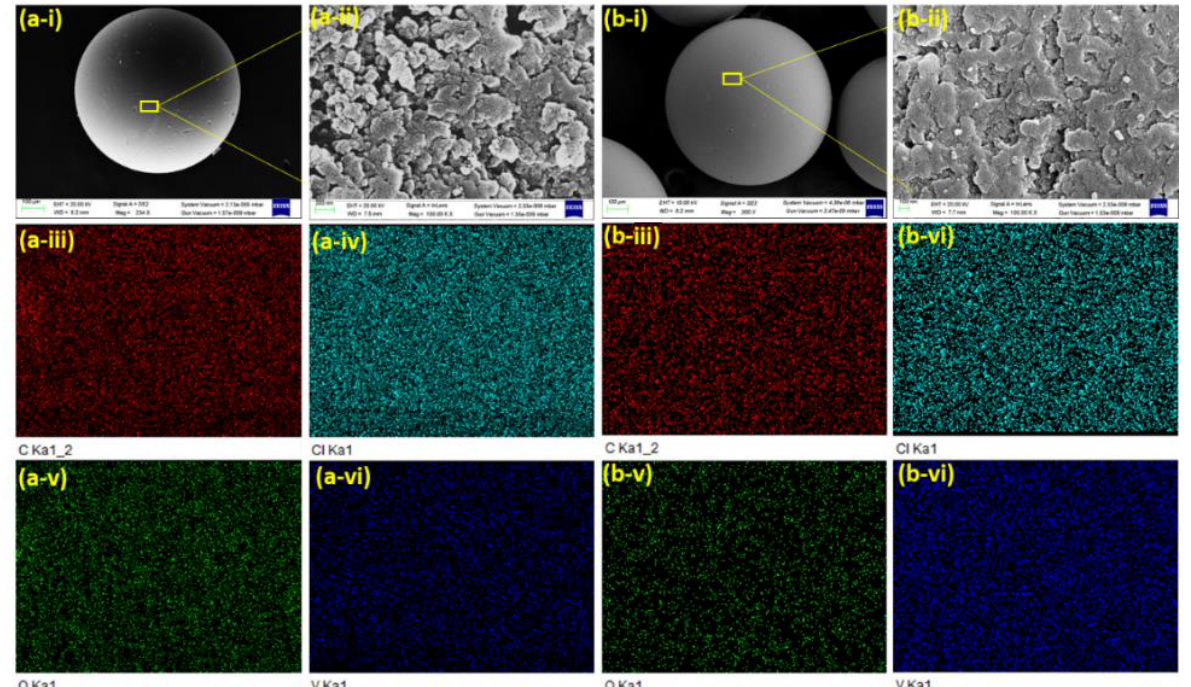
Figure 15. ( a-i ) FE-SEM image of 3 , ( a-ii ) high-resolution FE-SEM image of 3 , ( a-iii ) elemental mapping of carbon in 3 , ( a-iv ) elemental mapping of chlorine in 3 , ( a-v ) elemental mapping of oxygen in 3 and ( a-vi ) elemental mapping of vanadium in 3 . ( b-i ) FE-SEM image of 4 , ( b-ii ) high-resolution FE-SEM image of 4 , ( b-iii ) elemental mapping of carbon in 4 , ( b-iv ) elemental mapping of chlorine in 4 , ( b-v ) elemental mapping of oxygen in 4 and ( b-vi ) elemental mapping of vanadium in 4 .